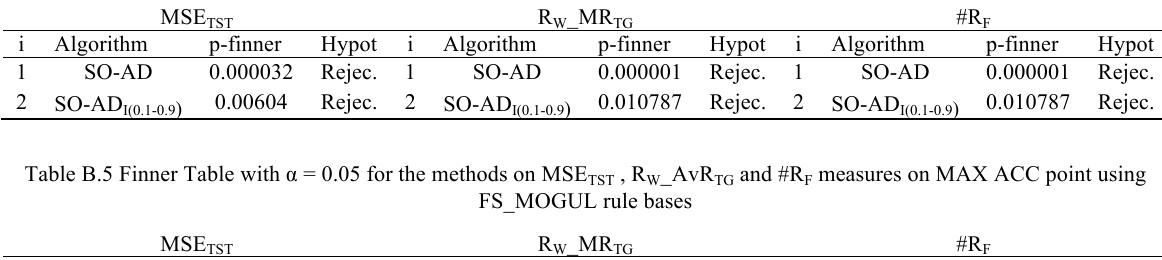
Table B.4 Finner Table with α = 0.05 for the methods on MSE TST , R W _AvR TG and #R F measures on MAX ACC point using